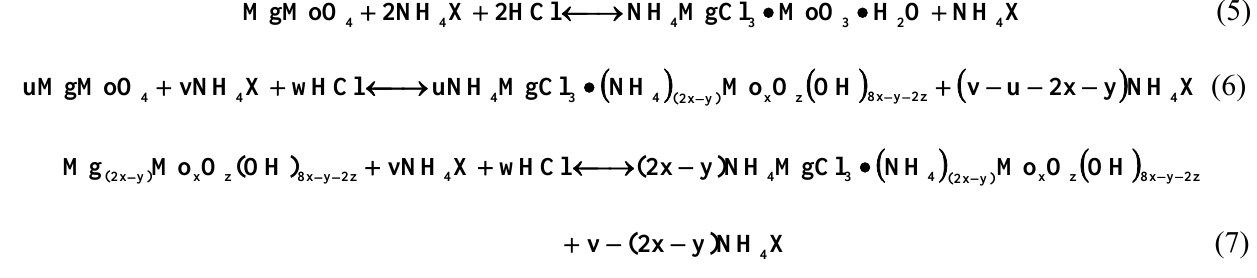
diffraction data (see Table 2 and Figure 2) suggests polymetalates formation such as (cid:120) yMoO xNH MgCl or polymolybdates according 4 3 3